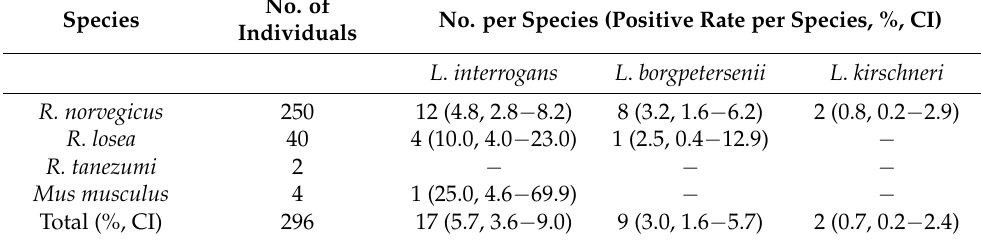
Table 3. Distribution of pathogenic Leptospira species among rodents.